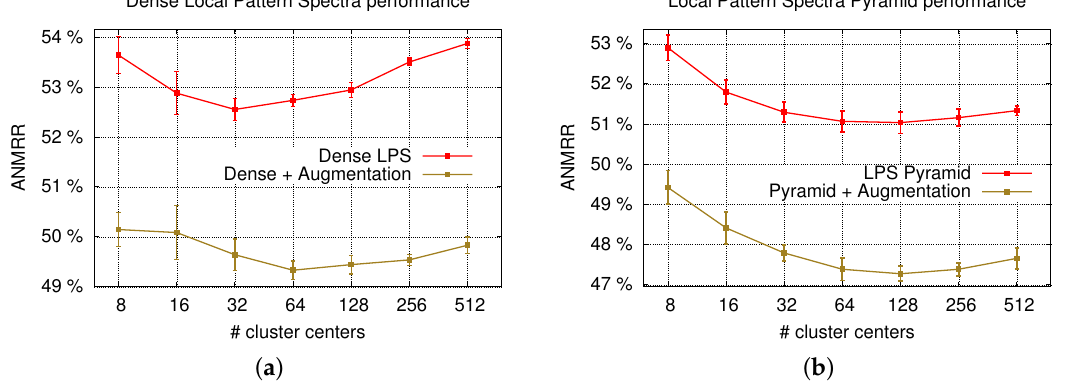
Figure 7. Experiments showing the influence of the number of VLAD cluster centers as well as using the descriptors based on augmented data. In ( a ), the retrieval results when calculating the LPS on a densely sampled image are shown. The results when using a pyramid of patches are shown in ( b ). Each data point was obtained by repeating the experiments between 10 and 20 times with different random values used to initialize the VLAD clustering. The error bars on the figures express the scatter in the results, and correspond to one standard